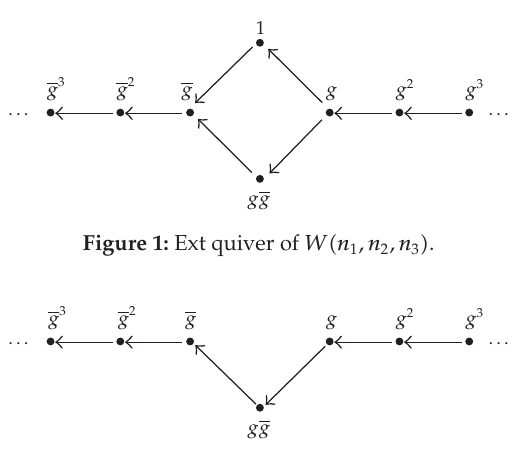
Figure 2: A subquiver of Ext quiver of W (cid:4) n 1 ,n 2 ,n 3 (cid:5)